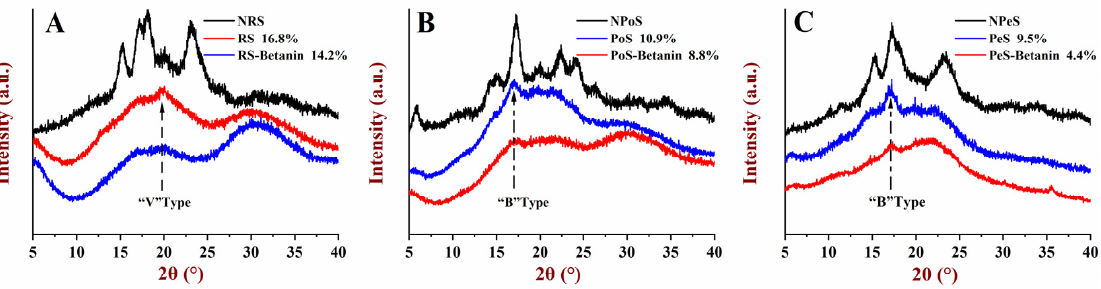
Figure 4. XRD diagrams of starches and starch–betanin samples after retrogradation; ( A ) rice starch, ( B ) potato starch, and ( C ) pea starch. NRS: native rice starch; NPoS: native potato starch; NPeS: native pea starch. RS: retrograded rice starch; PoS: retrograded potato starch; PeS: retrograded pea starch.